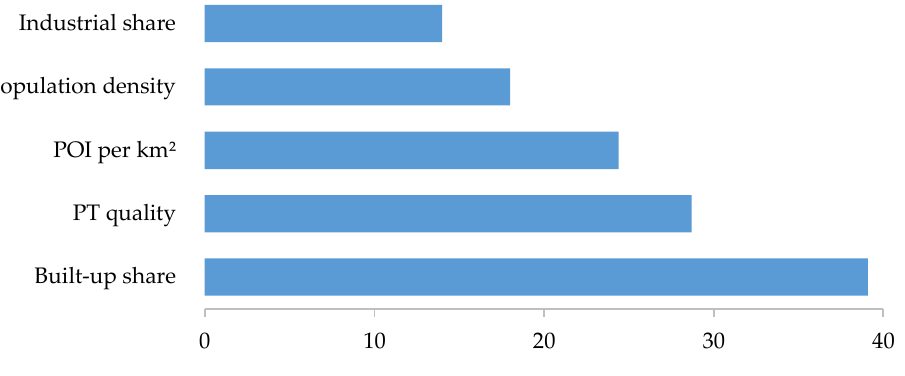
Figure 2. Variable importance measures .